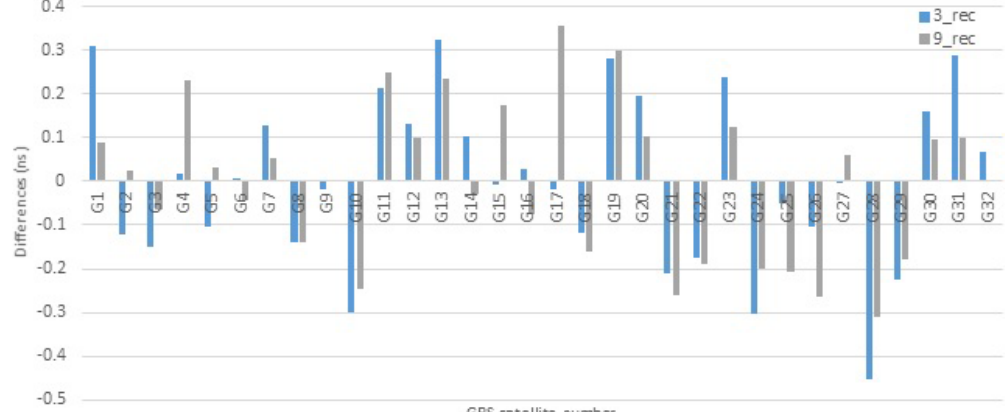
Figure 6. Mean difference between the satellite DCB values of the IGS and the computed values by MSDCBE estimated from 1 to 5 Jan- uary 2010.